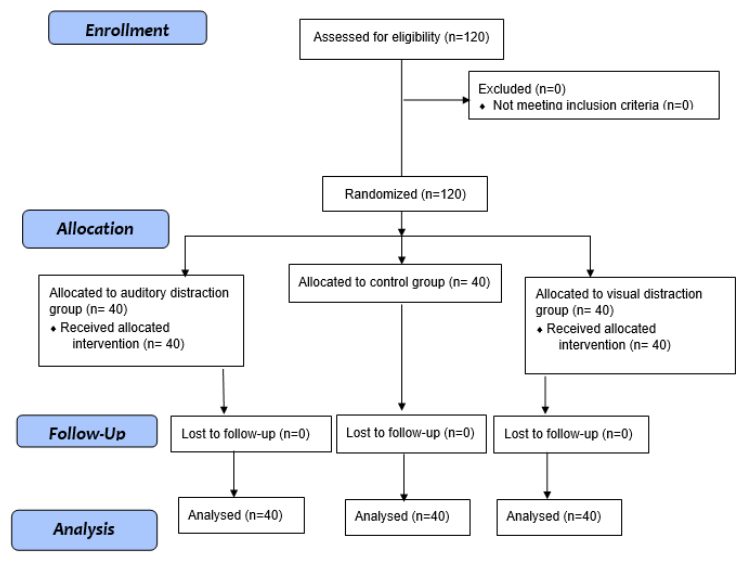
Figure 1. The process of the study according to the Consort flow diagram.